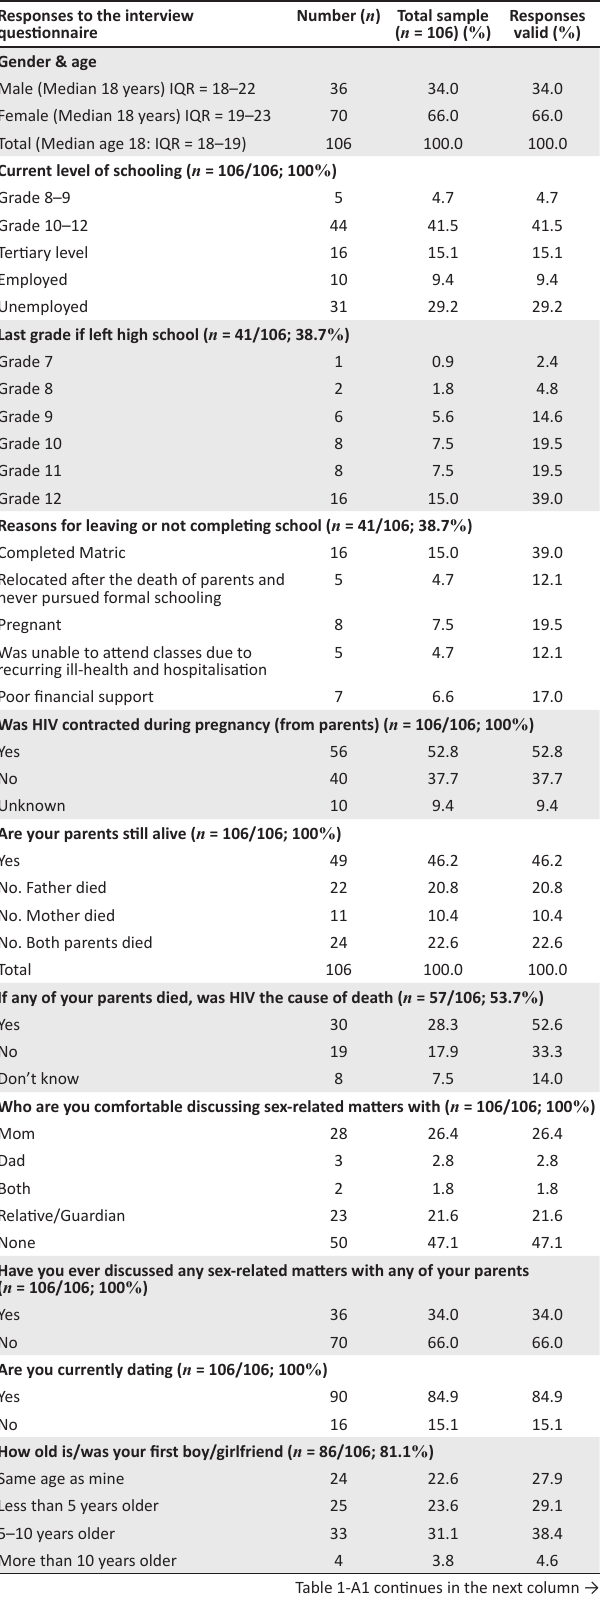
TABLE 1-A1: Responses to the interview questionnaire. Responses to the interview questionnaire